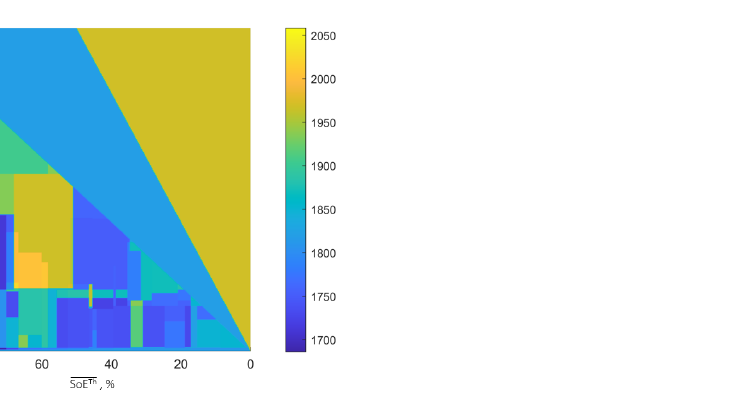
Figure 6. Daily operating cost [ € ] yielded by the TRBH approach with one intra-day window, as a function of the SoE thresholds.